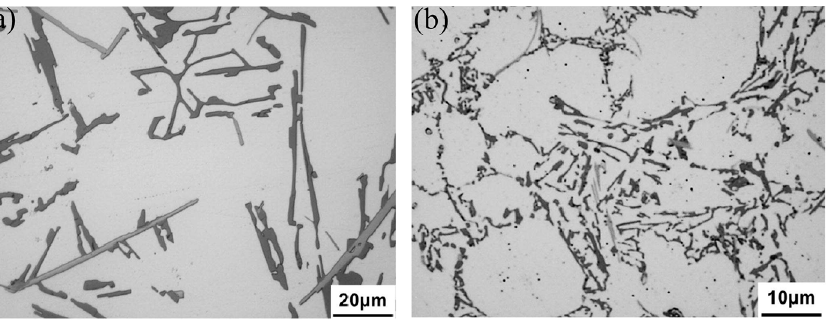
Figure 5. The microstructure of ( a ) gravity casting and ( b ) die casting Al-Si-Cu-Fe-Zn alloys [29]. Today, over 50% of cast aluminum alloys are fabricated by die casting [5,33].